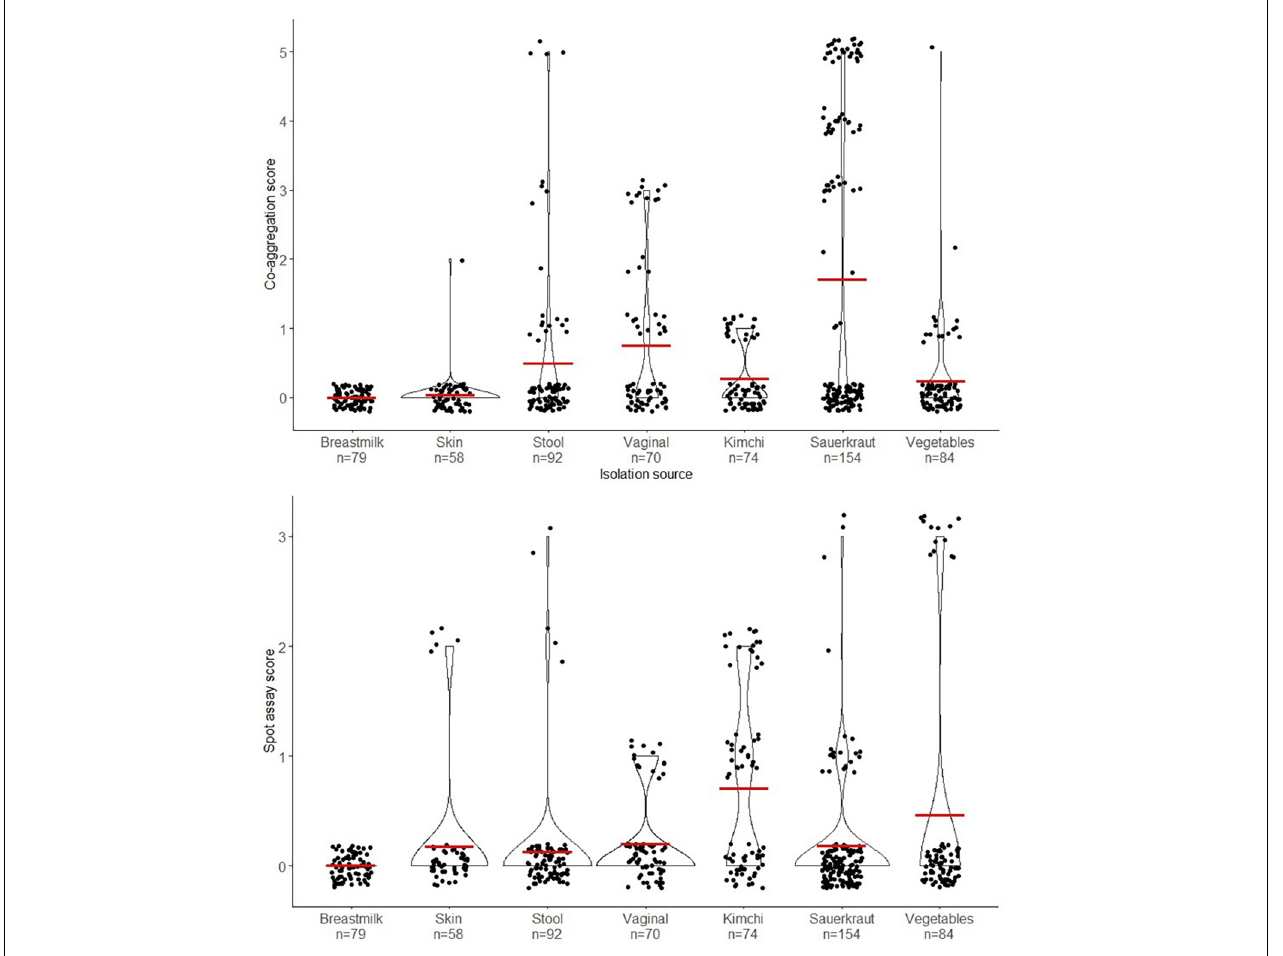
FIGURE 2 | Violin plot illustrating the distribution of all the isolates from the primary screen and their isolation source. The upper graph shows the distribution according to co-aggregation score (0–5) and the lower graph shows the distribution of the isolates according to the spot on lawn assay score (0–5). The red crossbar shows the mean of the assay scores for each isolation